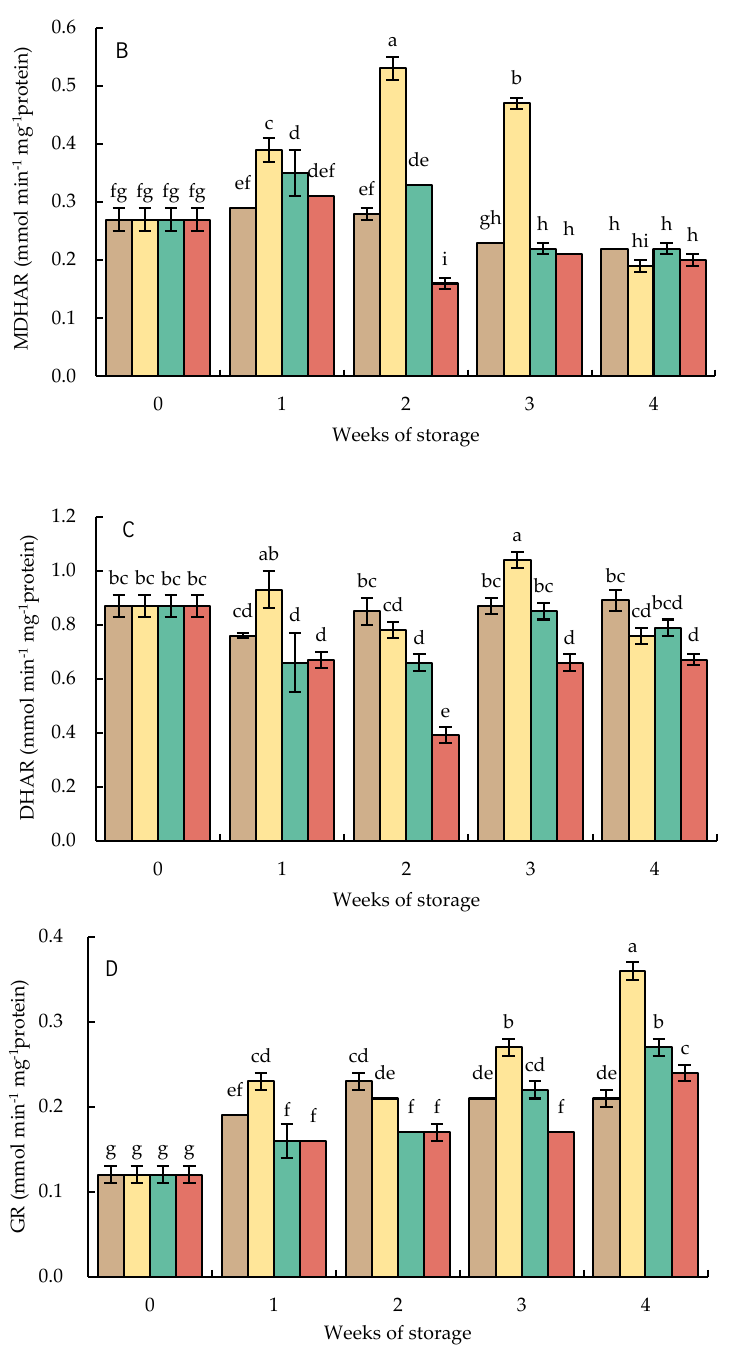
Figure 11. Effect of hot water treatment (55 ◦ C for 1, 3, 5 min) on the activity of ( A ) ascorbate peroxidase (APX), ( B ) monodehydroascobate reductase (MDHAR), ( C ) dehydroascorbate reductase (DHAR), and ( D ) glutathione reductase (GR) in red sweet pepper during storage at 10 ◦ C. Data represent means ± S.E. (n = 3). Different letters on bars are significantly different ( p < 0.05).